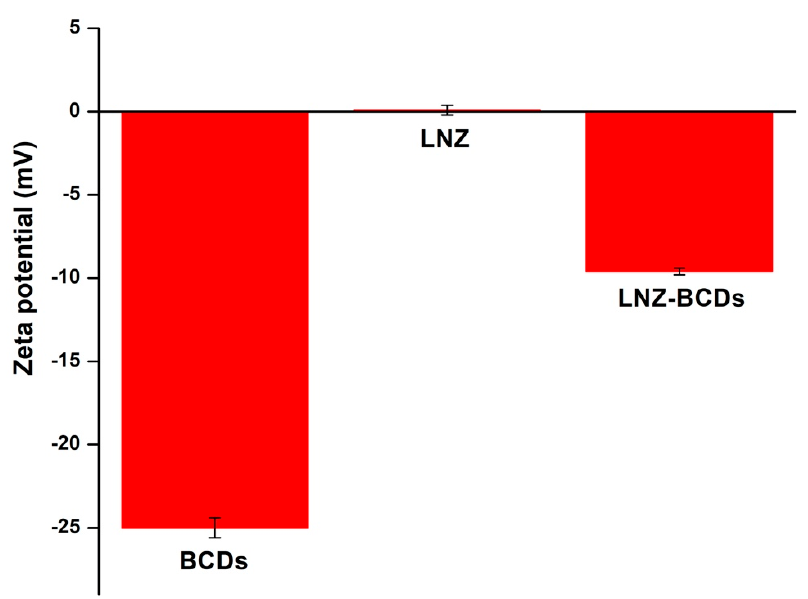
Figure 7. The ζ -potential measurements for BCDs nano-biocarrier, LNZ drug molecules, and LNZ– BCDs nano-bioconjugate.